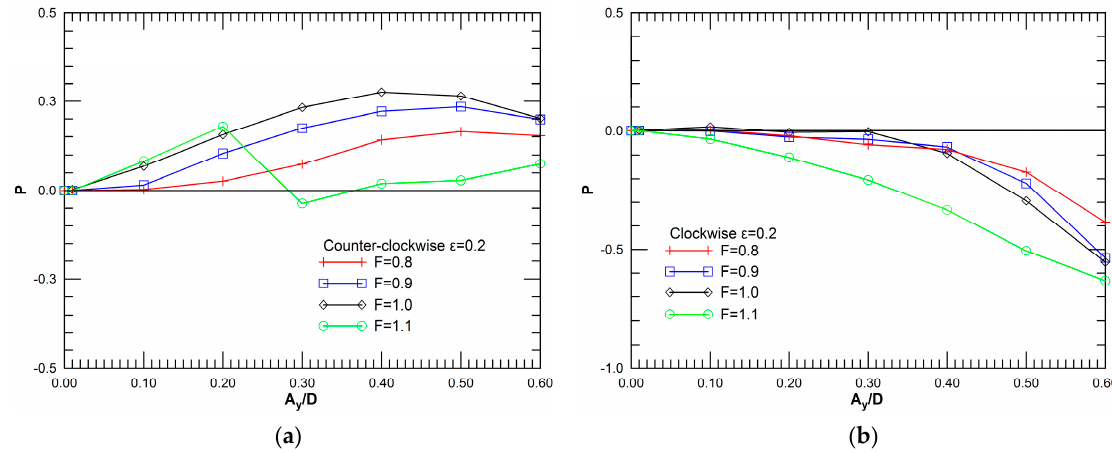
Figure 3. Variation of the power transfer parameter, P, for ε = 0.2, versus the non-dimensional amplitude A y /D, for frequency ratio F = 0.8, 0.9, 1.0, 1.1: ( a ) counter-clockwise cylinder oscillation, ( b ) clockwise cylinder oscillation.